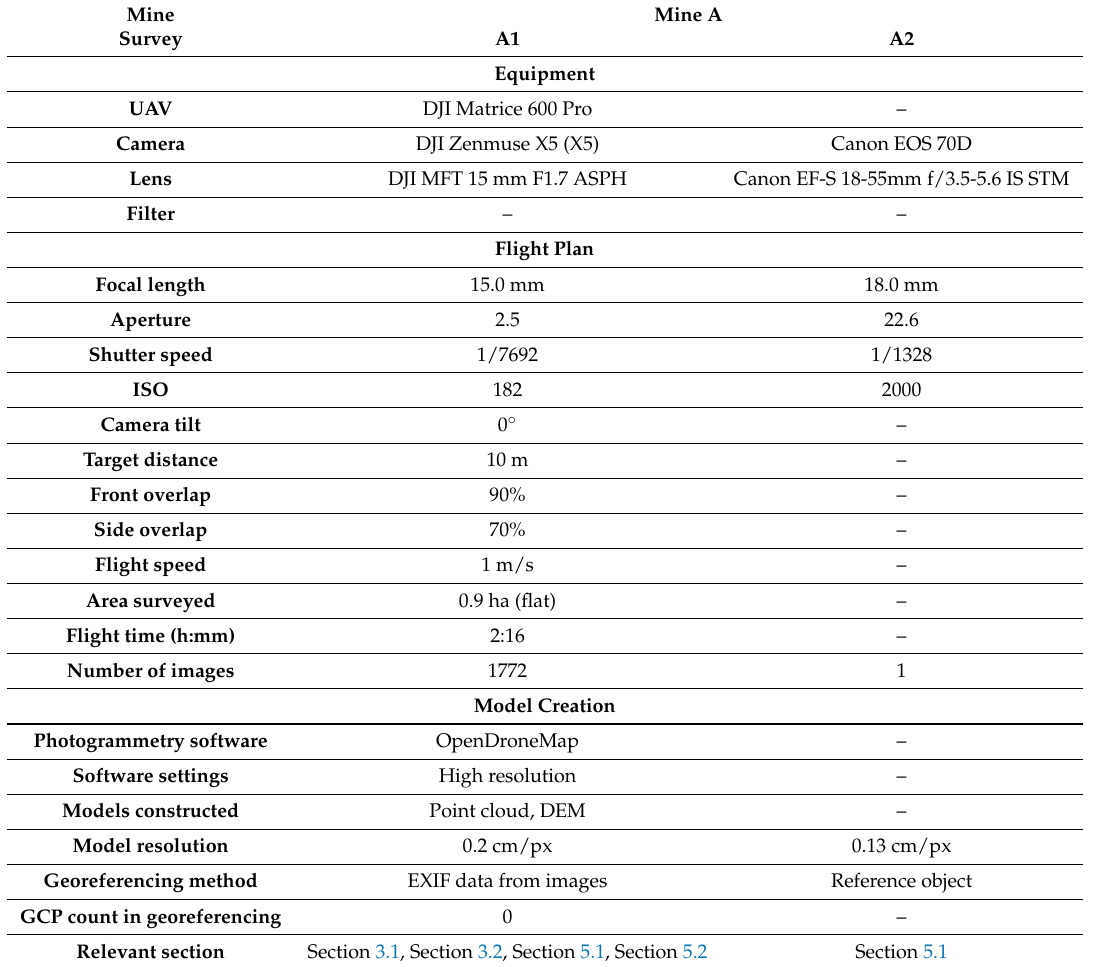
Table A1. Workflow for Mine